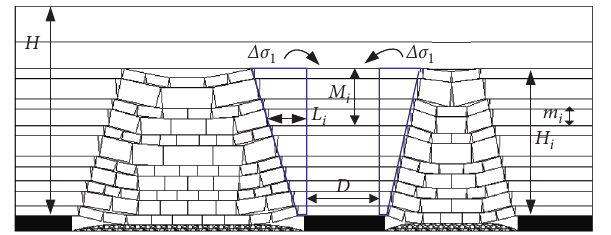
Figure 10: Mechanical model of overlying rock